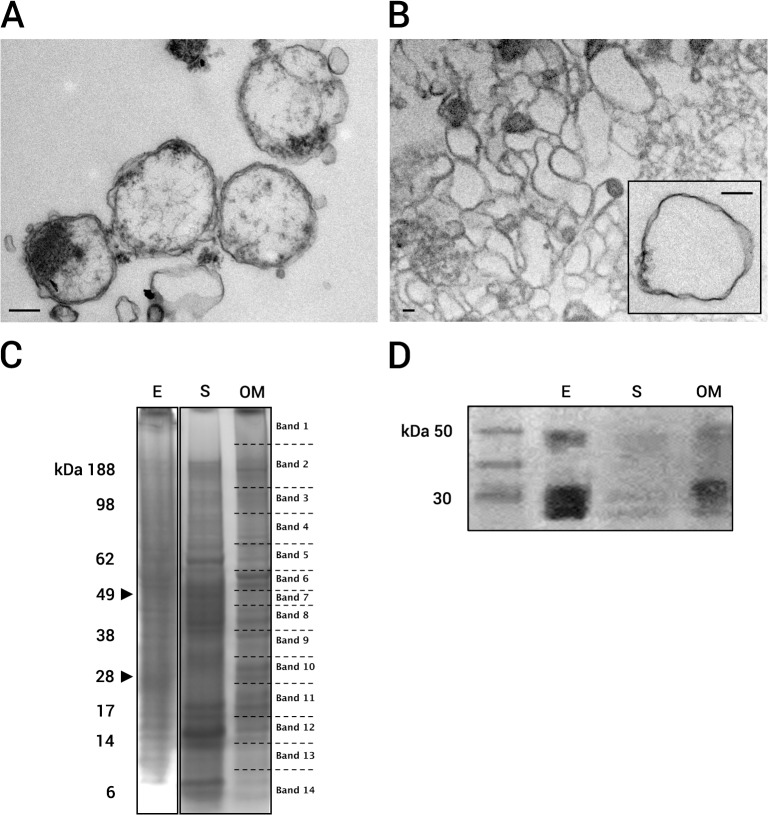
Evaluation of OM isolation quality.Transmission electron microscopy of (A) purified E. ruminantium and (B) the insoluble precipitate after 0.1% sarkosyl treatment; scale bar = 200 nm. (C) SDS-PAGE and (D) Western blot of E (elementary bodies), S (sarkosyl-soluble fraction), and OM (outer membrane fraction) using monoclonal antibodies against Map1. Band 1: Map1-14, X5HG56, GroEL; Band 2: Map1+1, Map1, Map1-6, VirB10, VirB4, GroEL, PyrE, Q5HAR6, X5HG56, 30S-S8; Band 3: Map1+1, Map1-6, Map2, GroEL, PyrE, Q5HAR6, X5HG56, Q5FGC2, Q5HBI2, Q5FHJ9; Band 4: Map1, Map1-6, VirB4, GroEL, DnaK, BamA, FusA, Pnp, Q5HAR6, X5HG56, Q5FH07, Q5HBS6; Band 5: VirB4, VirB10, VirB11, DnaK, HtpG, GroEL, FusA, 30S-S1, Q5FGV5, Q93FS2; Band 6: Map1, Map1-14, VirB10, PleD, GroEL, DnaK, FtsZ, 30S-S1, Q5HB83, Q5FGA7, Q5HBE1; Band 7: Map1-14, GroEL, DnaK, FtsZ, HtpG; Band 8: Map1-6, Map1, GroEL, DnaK, FtsZ, BamA; Band 9: Map1-6, Map1, Map1+1, Map1-14, GroEL, DnaK, BamA, Q5FFE6, Q5HAR6; Band 10: Map1-11, Map1-13, Map1, Map1+1, Map1-6, VirB10, VirB9, Q5FFE6, Q5HAR6, Q5HBI2, Q5HA95; Band 11: Map1, Map2, BamA, DnaK, GroEL, FusA, Def, 50S-L4, PyrE, X5HG56, Q5HBI2; Band 12: 30S-S18, 30S-S12, 50S-L7/L12, 50S-L18, 50S-L24, 50S-L28 X5HG56, Q5HBN6; Band 13: HupB, X5HG56; Band 14: 30S-S12, 50S-L7/L12, 50S-L18, GroEL, YajC, PyrE.